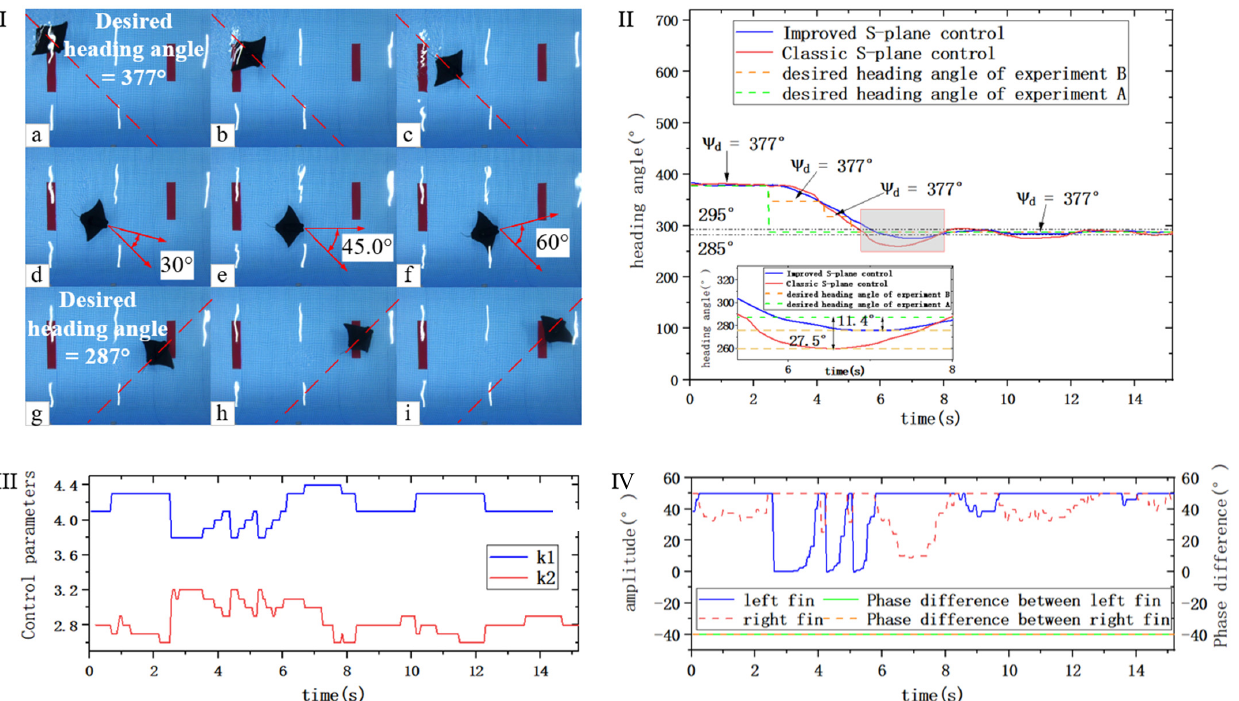
Figure 10. Heading switching 90° experiment. ( I ) Swimming frame diagram of the manta robot, where (a)–(i) represents the time order. ( II ) Heading angle data graph of the manta robot. ( III ) Controller parameter change curve graph. ( IV ) Data plot of pectoral fin motion parameters of the manta robot.